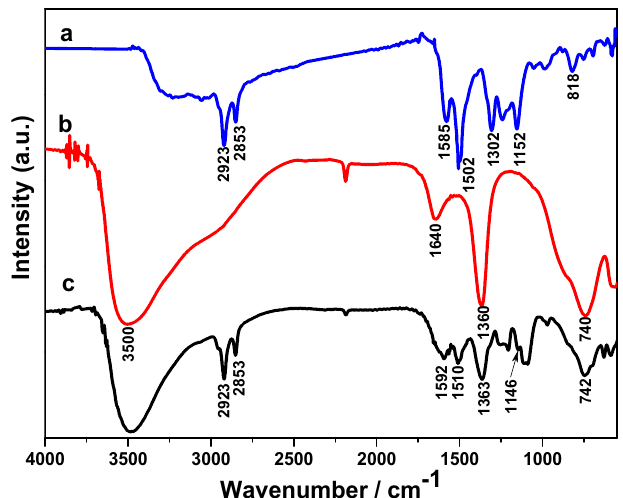
Figure 2. FT-IR spectra of (a) PANI, (b) CoAl LDH, and (c) CoAl LDH-PANI composite.